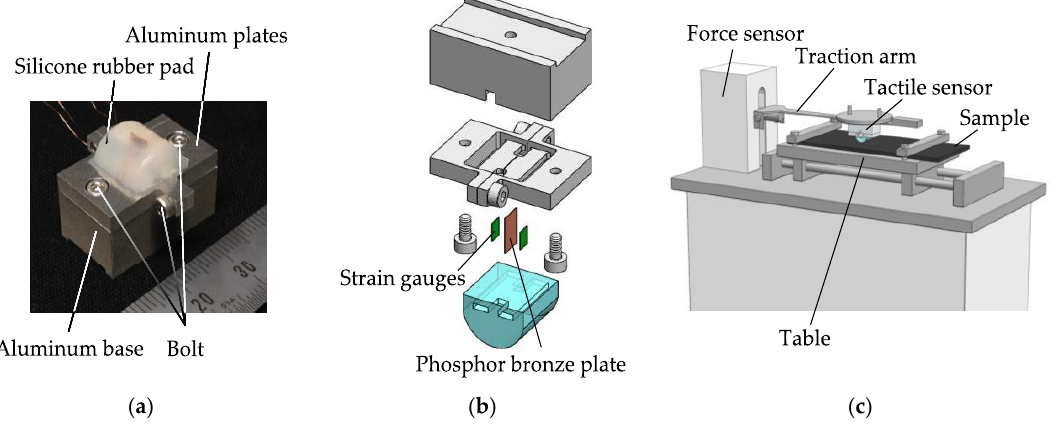
Figure 2. Tactile sensing system with developed tactile sensor. ( a ) Actual image of the sensor; ( b ) exploded view drawing of the sensor; and ( c ) overall view of the sensing system. The drawing in ( c ) shows the tactile sensor runs over a sample as a result of the sliding of the table. The strain gauges of the sensor detect vibration, while the force sensor measures the tangential force.